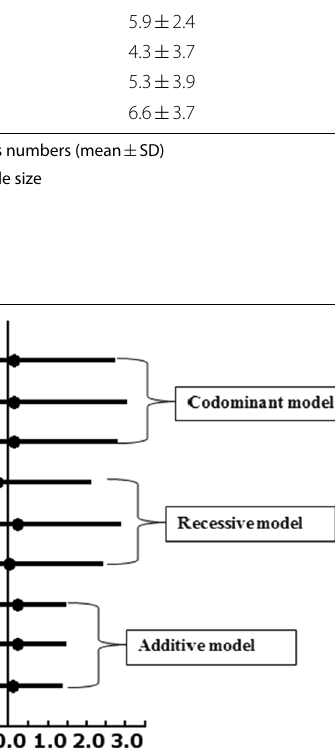
Fig. 1 Forest plots of mean differences in psychological components (depression, anxiety, and stress) with rs1501299 allele in the codominant, recessive and additive